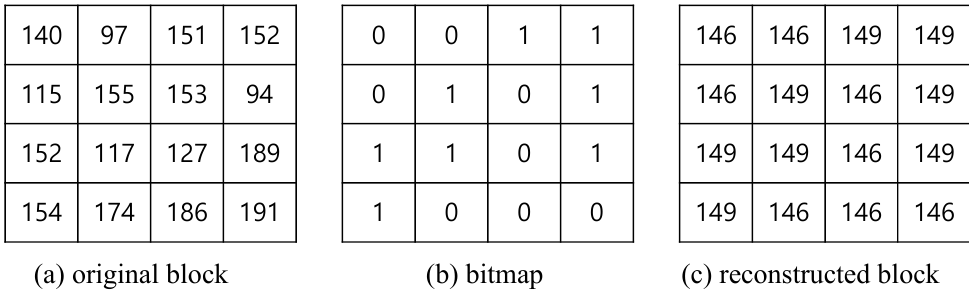
Figure 3. An example of AMBTC; ( a ) original block; ( b ) a bitmap; ( c ) reconstructed block.